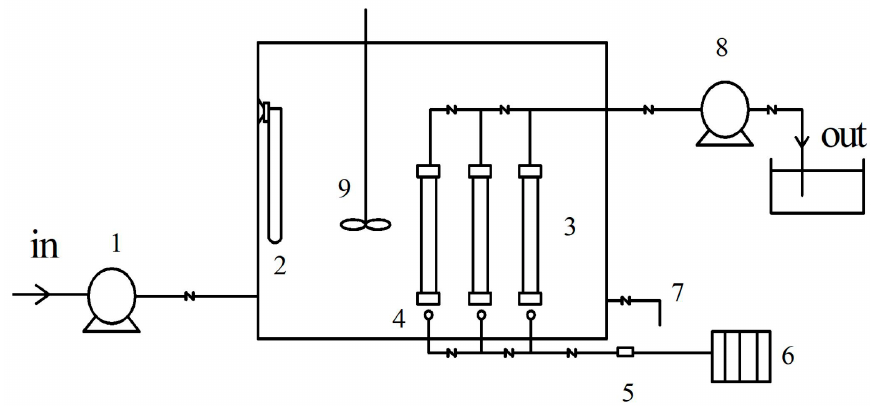
Figure 1. Facultative MBR flowchart: 1. influent pump, 2. temperature controller, 3. flat ceramic membrane, 4. aeration device, 5. gas flowmeter, 6. air pump, 7. emptying pipe, 8. effluent pump, 9. agitator.